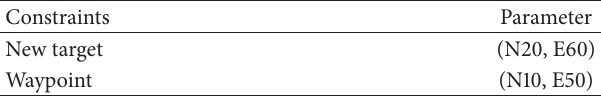
Table 6: Parameters of the geographic constraints (Case 2).